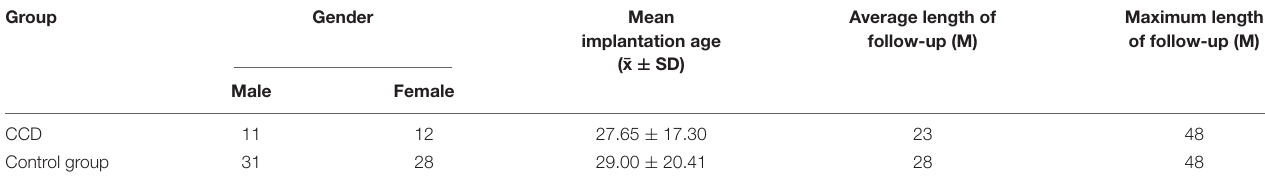
TABLE 1 | Demographic information of the recruited patients. Group Gender Mean